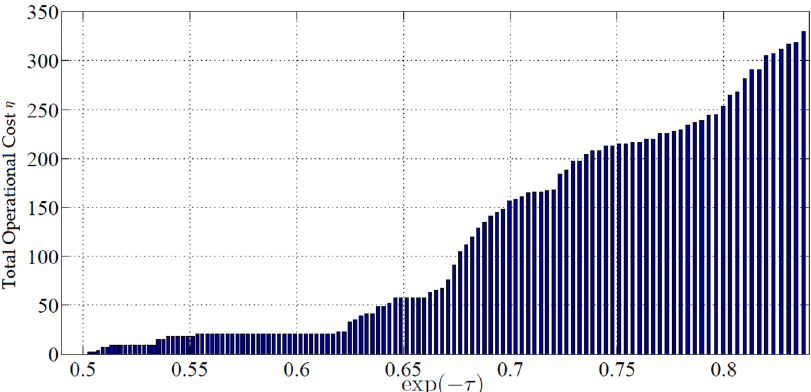
Figure 4. The maximum allowed total operational cost η versus the minimum obtained survivability probability in P1.